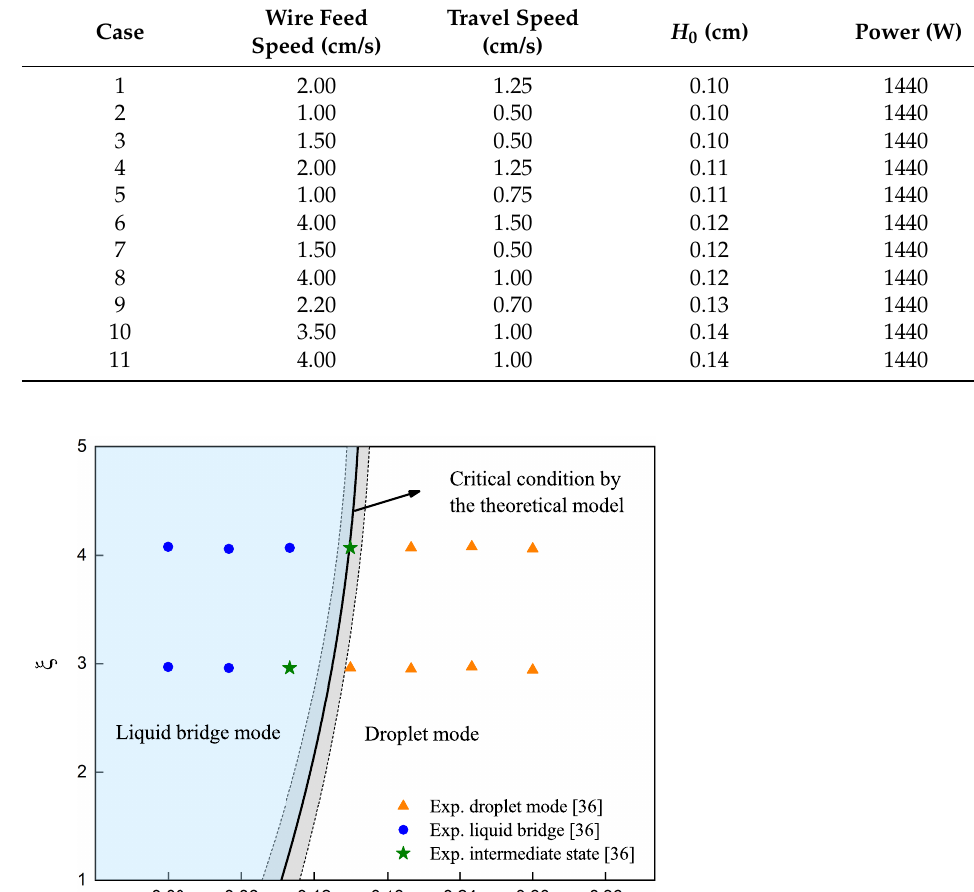
Table 5. Numerical cases to validate the prediction model for liquid bridge–droplet transition.